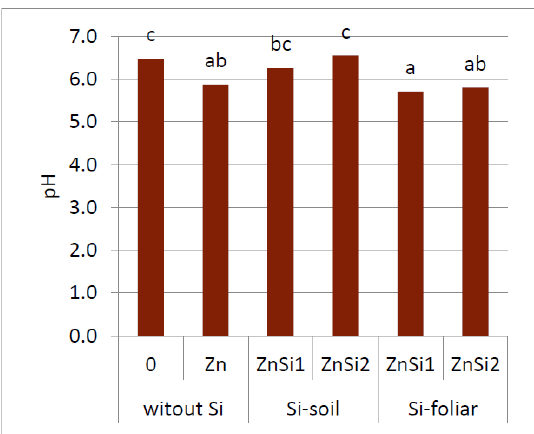
Figure 5. Soil pH. Values marked with the same letters indicate no significant difference according to Tukey ’ s test ( p < 0.05).